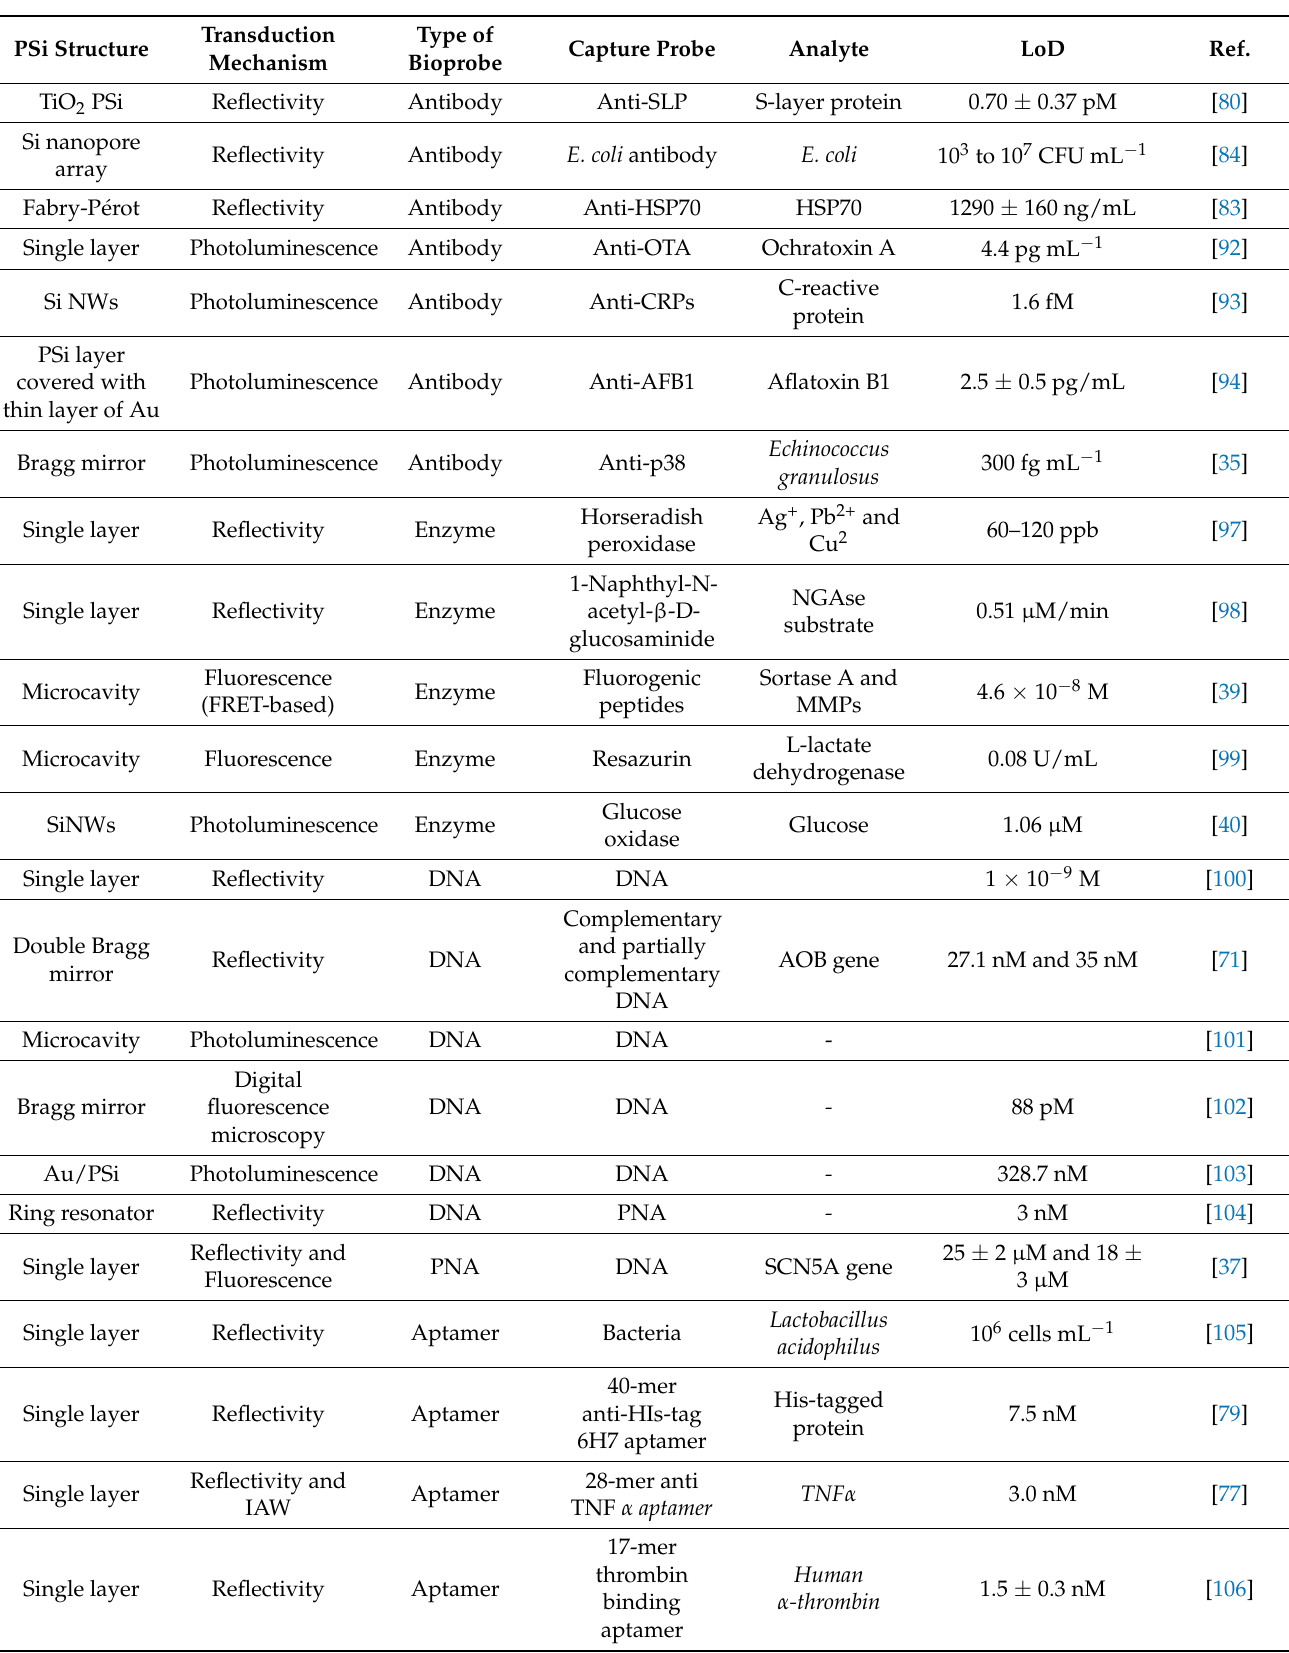
Table 1. Summary of detection of various Biomolecules using PSi optical device as a transducing